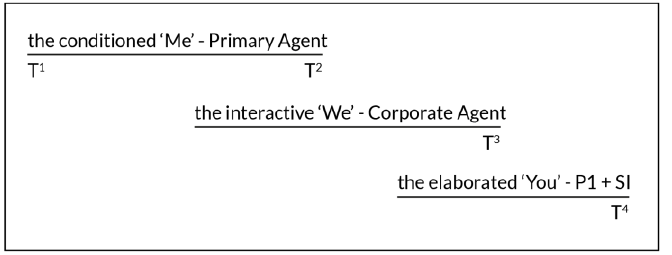
Figure 2 : The morphogenesis of personal and social identity Triple morphogenesis in higher